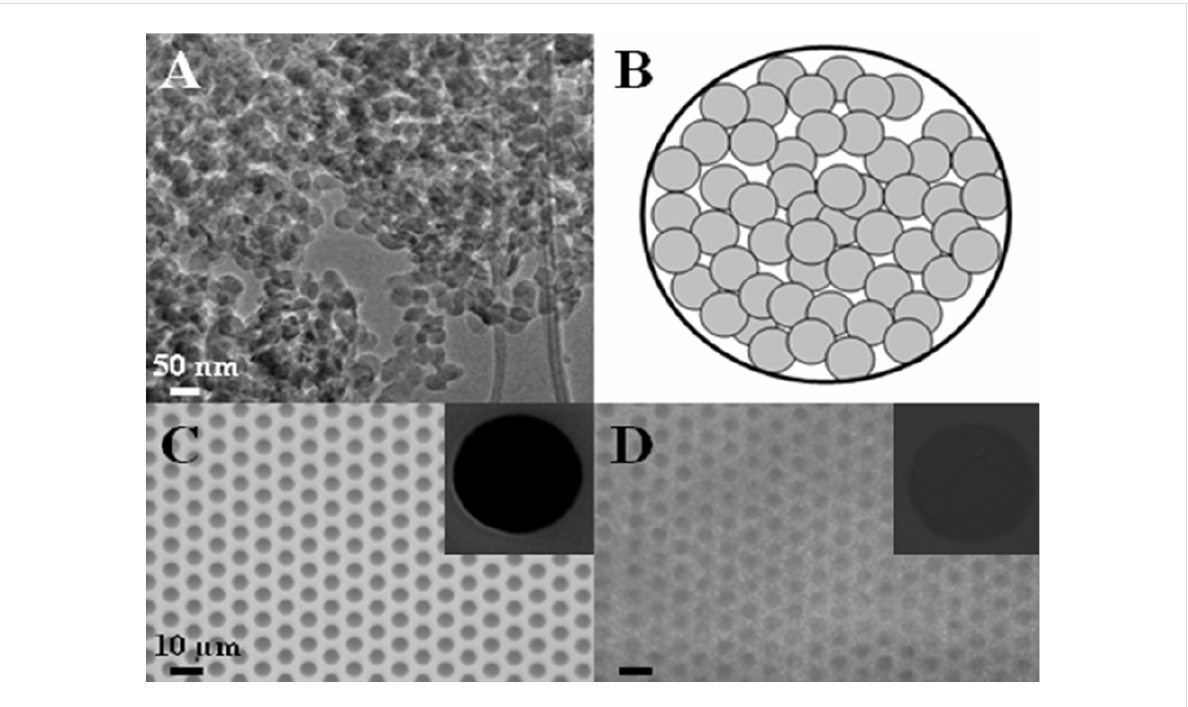
Figure 2: TEM micrograph of 75TEOS/25PS 308 - b -PEO 250 silica nanoparticles (A), schematic top-view of a depth-filter functionalized 5 μ m pore (B), optical micrograph of a Si 3 N 4 microsieve before (C) and after (D) fuctionalization with silica nanoparticles. Insets in pictures C and D show the SEM micrograph of a single microsieve pore collected at high